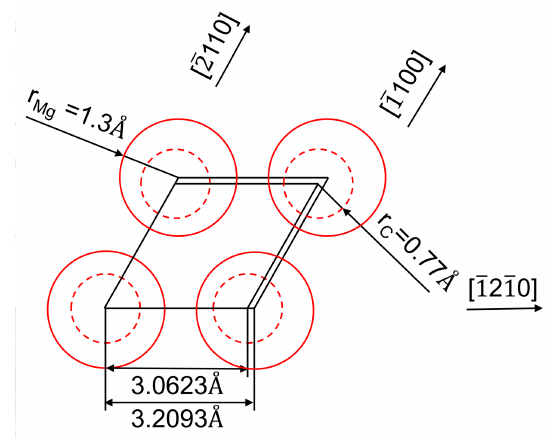
Figure 5. Crystallographic combination of Ti 2 AlC and Mg in (0001) planes (r Ti = 1.36 Å, r Al = 1.18 Å, r C = 0.77 Å, r Mg = 1.3 Å).